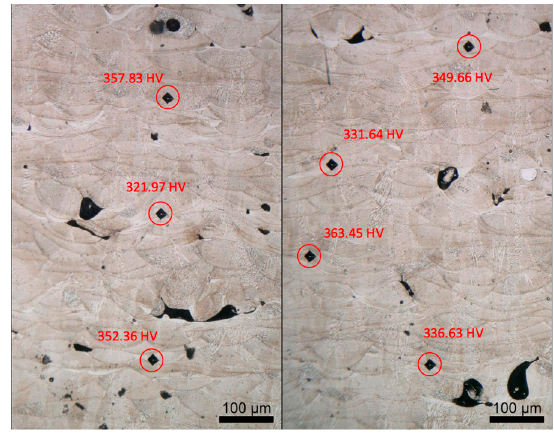
Figure 5. Microhardness test results.